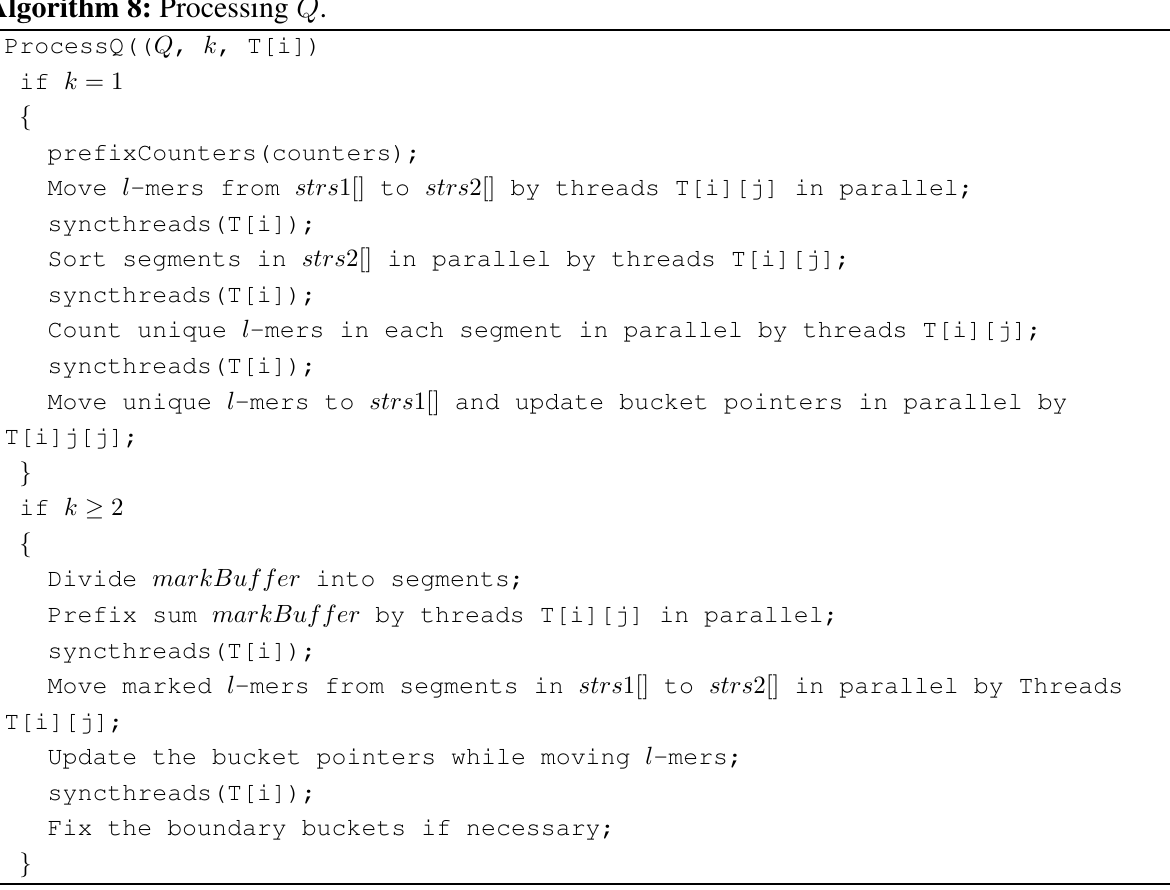
Algorithm 8: Processing Q